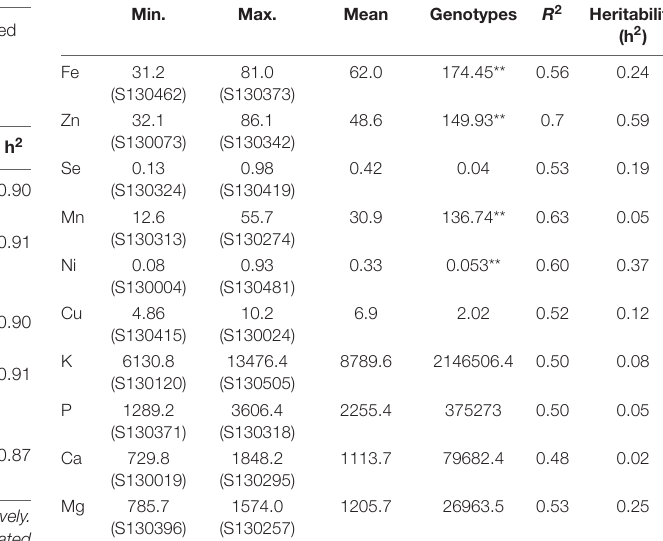
average of 25.31%. For all tested genotypes mean values of 62 ppm and 48.6 ppm were observed for iron (Fe) and zinc (Zn), respectively. Fe content ranged from a minimum of 31.2 (S130462) to a maximum of 81 ppm (S130373), while Zn contents ranged from 32.1 (S130073) to 86.1 ppm (S130342). Manganese (Mn) content varied from 12.6 (S130313) to 55.7 ppm (S130274). Copper (Cu), selenium (Se), and nickel (Ni) were found in lower amounts, ranging from 4.86 to 10.2 ppm, 0.13 to 0.98 ppm,